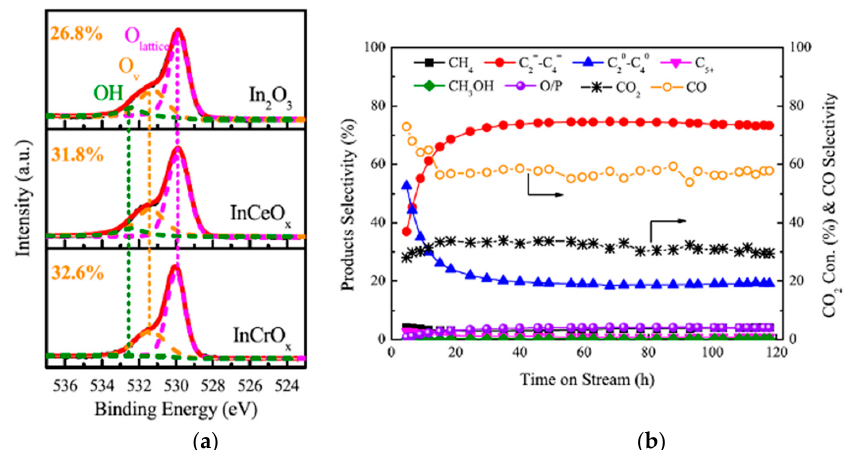
Figure 19. ( a ) The content of the surface oxygen vacancies (O v ) from O (1s) XPS spectra for the catalysts In 2 O 3 , InCeO x (0.13), and InCrO x (0.13). ( b ) The catalytic stability of the bifunctional composite catalysts InCrO x (0.13) and SAPO-34 for CO 2 hydrogenation (testing conditions: H 2 /CO 2 molar ratio = 3/1, T = 623 K, P = 3.5 MPa, and GHSV = 1140 mLg cat − 1 h − 1 ). Adapted with permission from ref. [119]. Copyright 2020 Elsevier.